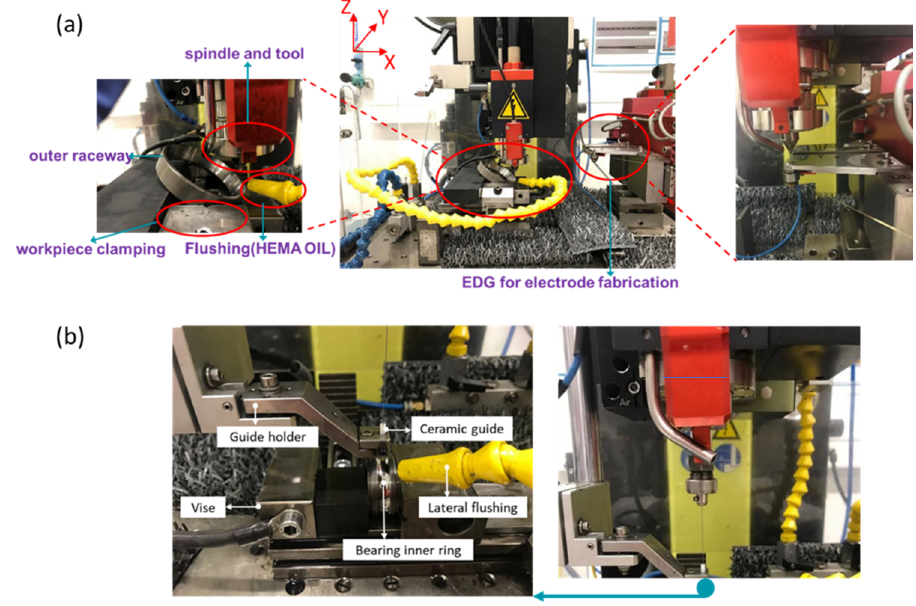
Figure 1. Micro-EDM ( a ) milling and ( b ) drilling set-ups for artificial defects machining.